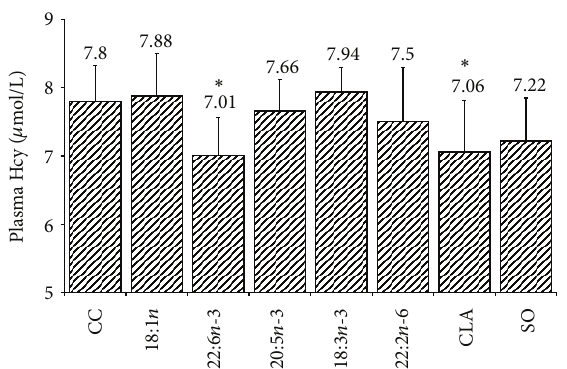
Figure 1: The effect of fatty acids on plasma Hcy concentration. 𝑛 - 10 , data was expressed as mean ± SD. ∗ indicate significant difference when compared with 18: 1 group. CC: control group; SO: stearolic